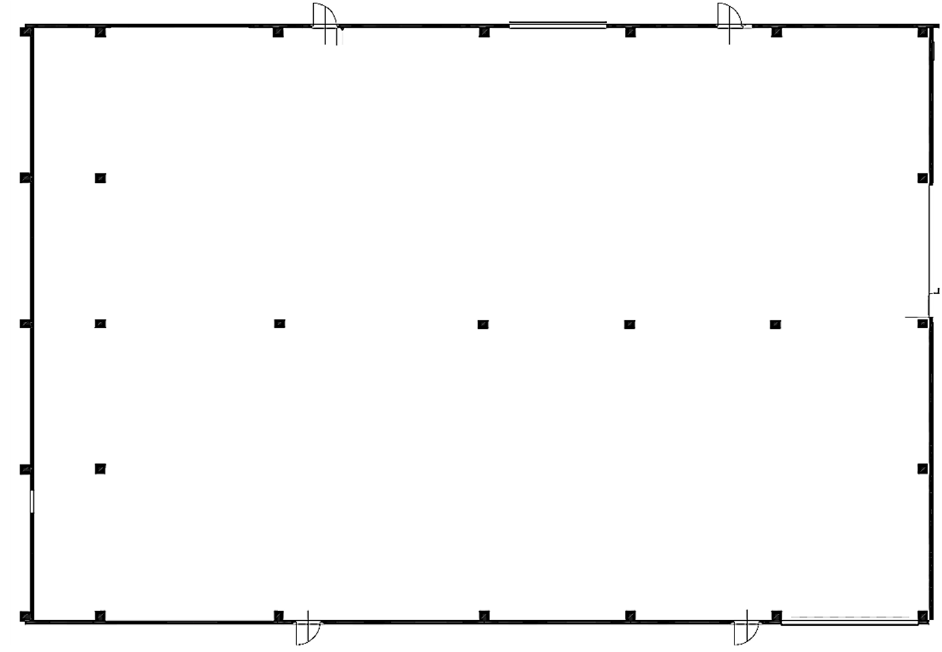
Figure 14. The plan of the warehouse. A proper set up was realized to carry out the test; in particular, anchor devices were placed on 3 m height poles as shown in Figure